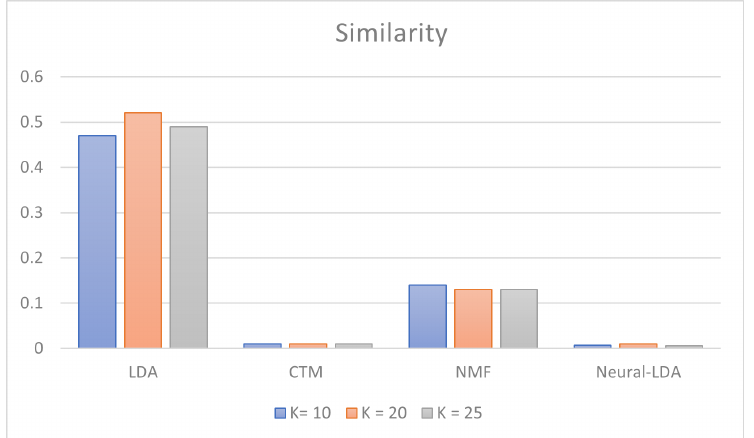
Figure 5. Similarity Bar graph.